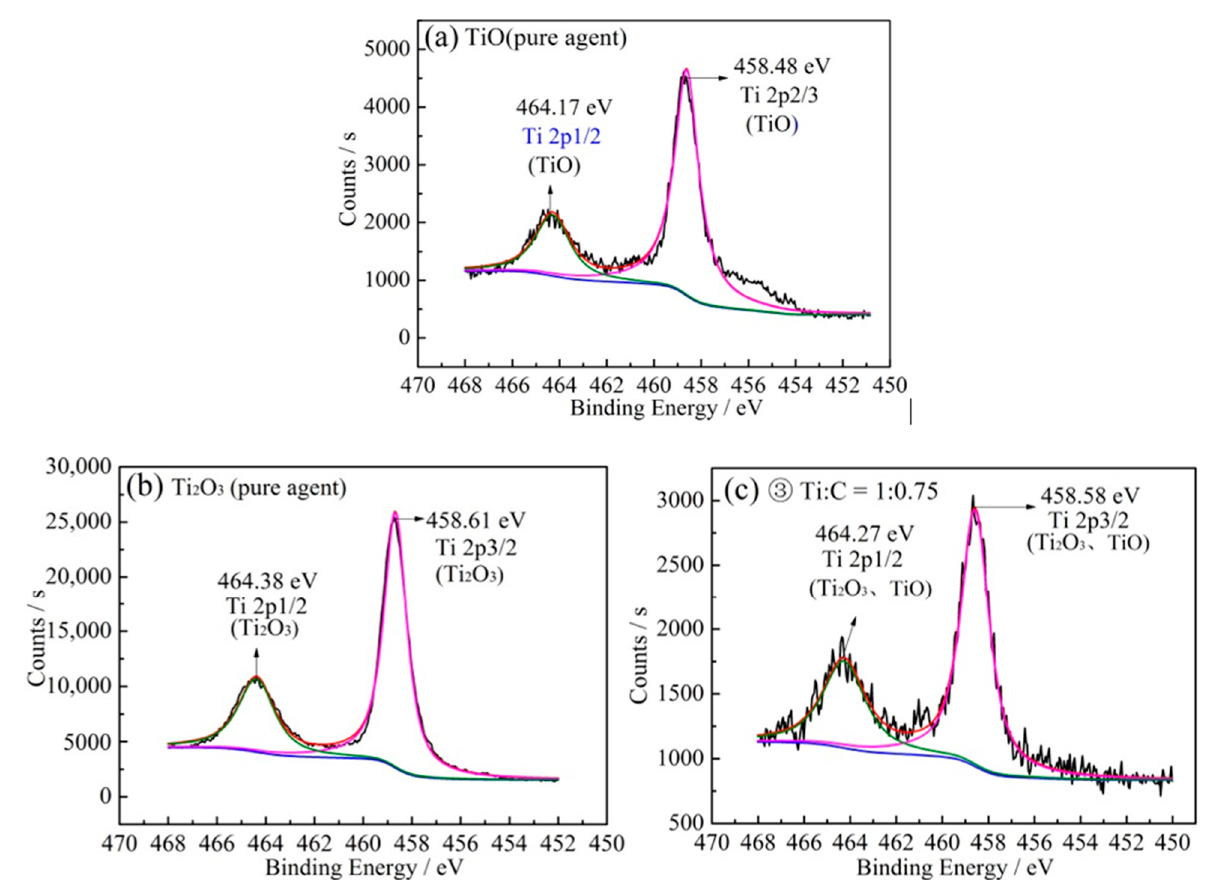
Figure 4. The Ti 2p2/3 and Ti 2p1/2 spectra of ( a ) TiO, ( b ) Ti 2 O 3 and ( c ) reduction product with Ti:C, 1:0.75.